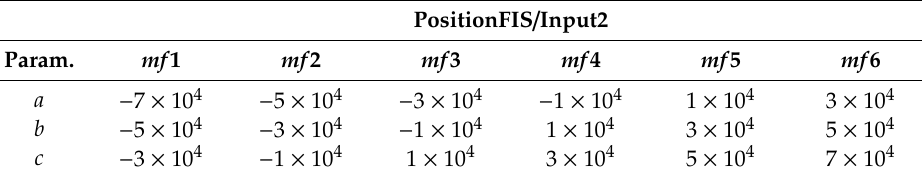
Table 3. Parameters of the mf for the second input of the